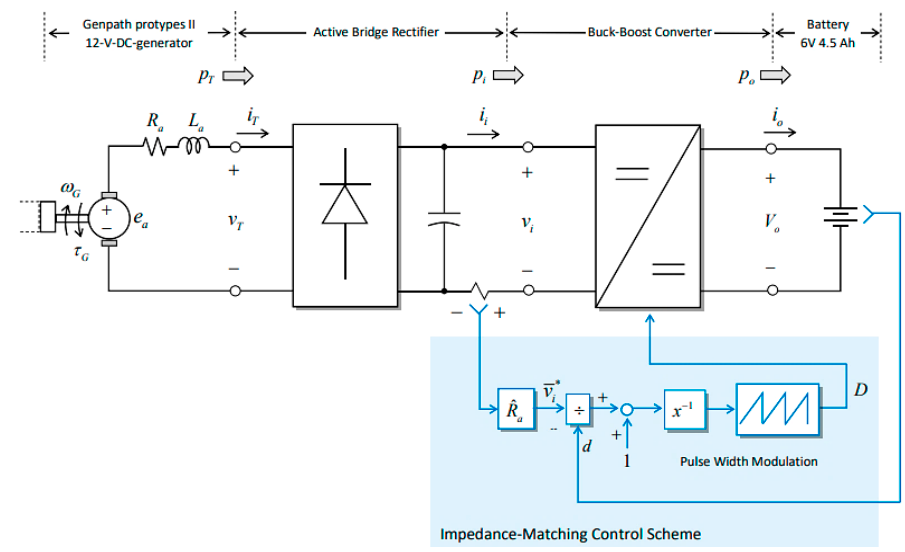
Figure 6. Example of a power management system of the EM harvester [36].